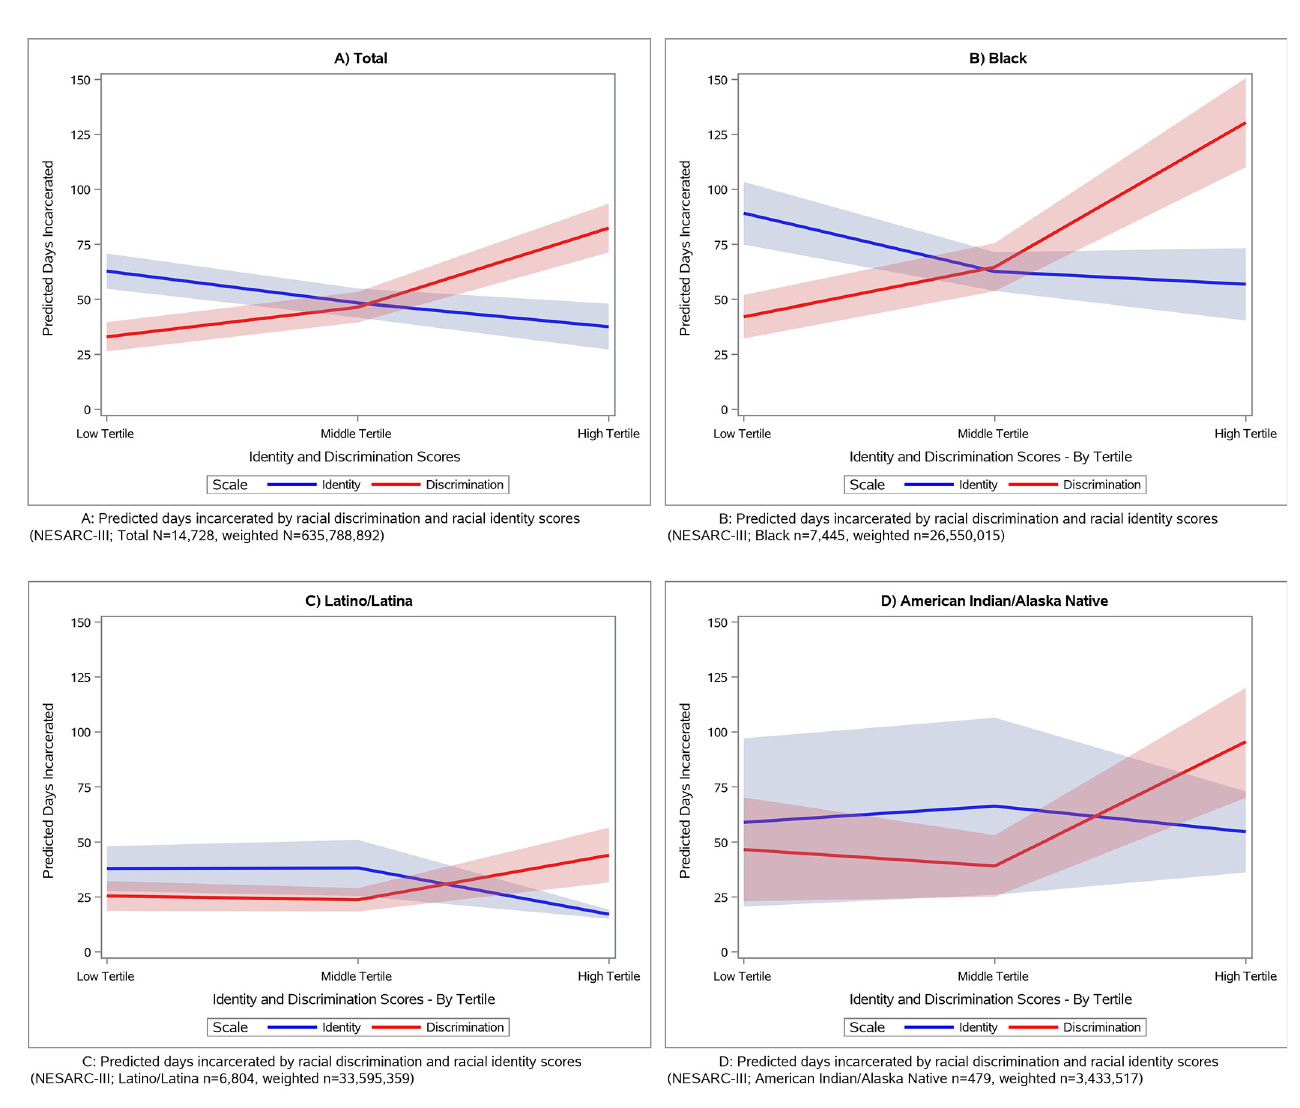
Fig 1. Predicted days incarcerated by racial discrimination and racial identity scores for the total sample and for Black, Latino/Latina, and American Indian/Alaska Native subgroups. A: Predicted days incarcerated by racial discrimination and racial identity scores (NESARC-III; Total N = 14,728, weighted N = 635,788,892). B: Predicted days incarcerated by racial discrimination and racial identity scores (NESARC-III; Black n = 7,445, weighted n = 26,550,015). C: Predicted days incarcerated by racial discrimination and racial identity scores (NESARC-III; Latino/Latina n = 6,804, weighted n = 33,595,359). D: Predicted days incarcerated by racial discrimination and racial identity scores (NESARC-III; American Indian/Alaska Native n = 479, weighted n = 3,433,517).